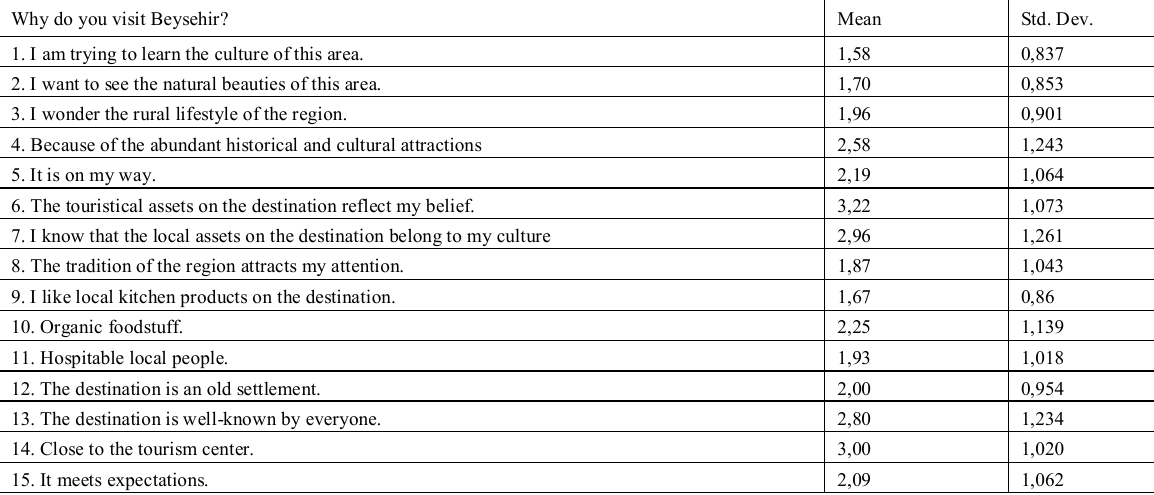
Table 2: Analysis of the Reasons of Participants for Visiting Beysehir Why do you visit Beysehir? Mean Std. Dev.